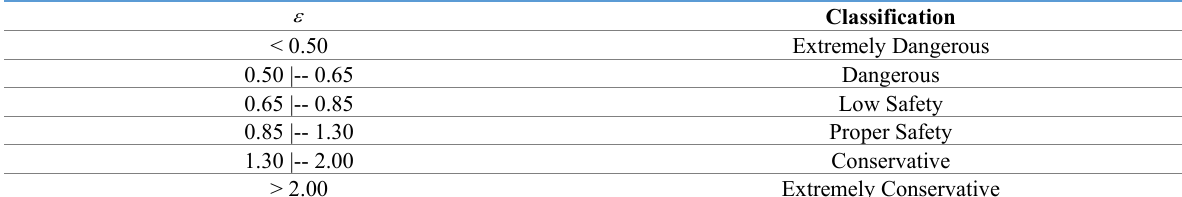
Table 1. Demerit scale for model